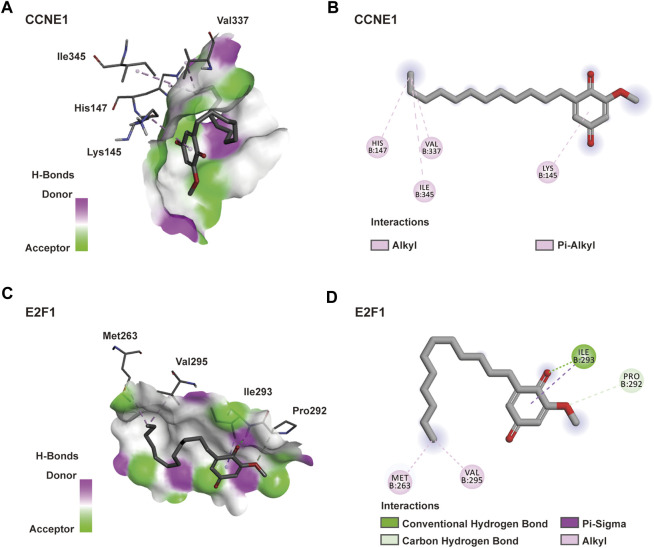
Docking model of DMDD with CCNE1 and E2F1. (A) DMDD binding with the pocket of CCNE1 is composed of hydrogen bonds. And the interaction pattern of DMDD with the residues. (B) 2D diagram between the CCNE1 and residues. (C) DMDD binding with the pocket of E2F1 is composed of hydrogen bonds. And the interaction pattern of DMDD with the residues. (B) 2D diagram between the E2F1 and residues.